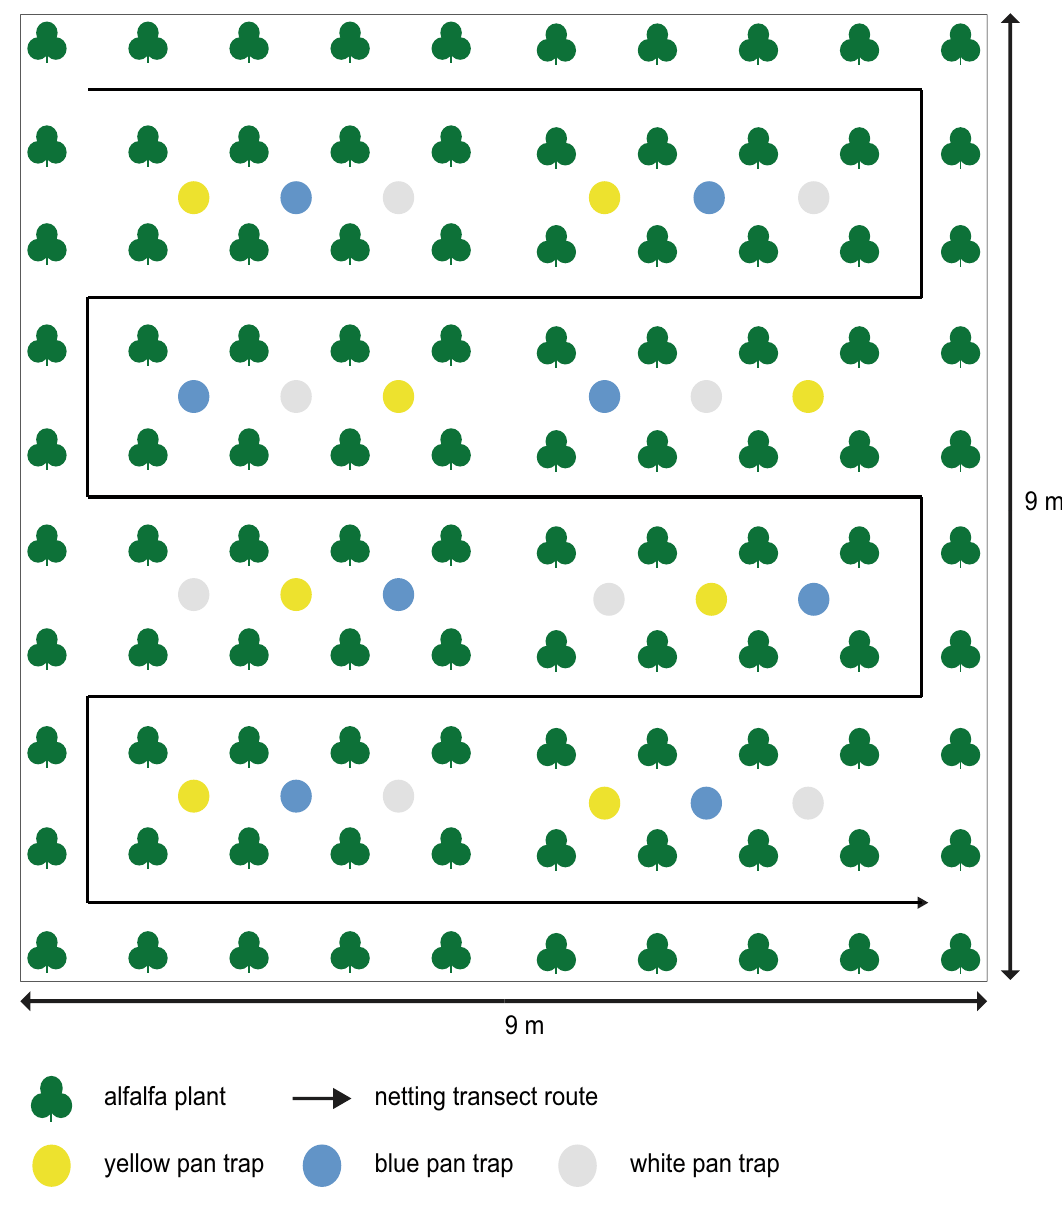
Figure 3. Arrangement of pan traps within an alfalfa patch. The green represents alfalfa plants while the white, blue and yellow dots illustrate the location of the pan traps of respective colors. The black line illustrates the transect lines used during